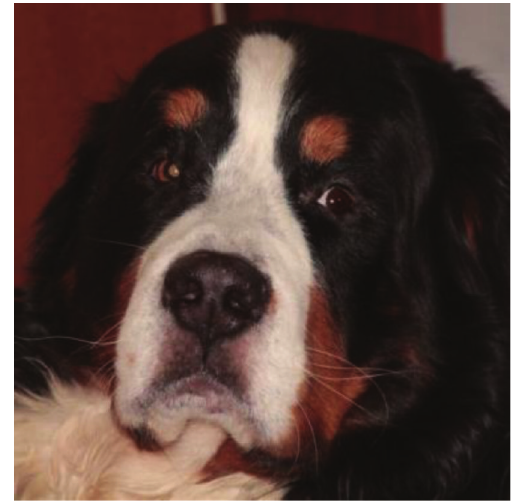
Figure 9: Two-year-old Bernese mountain dog one and a half year after